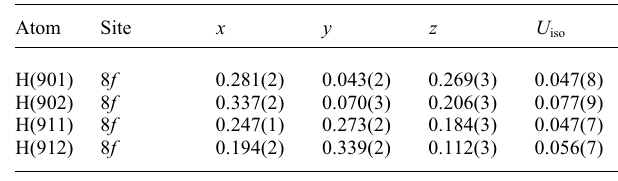
Table 3. Atomic coordinates and displacement parameters (in Å 2 )